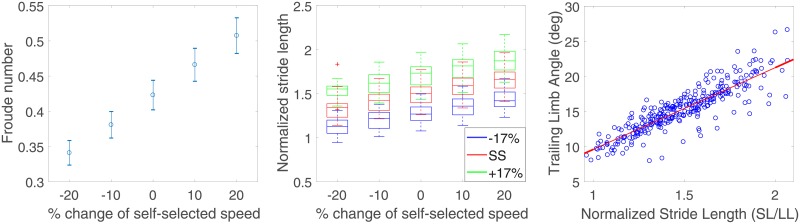
(Left) the distribution of mean Froude numbers with 95% confidence intervals at the various treadmill imposed GSs, (center) normalized stride lengths measured at various speeds and biofeedback conditions.The box plot shows the median as a horizontal line, and the box at 25% and 75% percentiles, with whiskers extending to ±3σ, and (right) mean trailing limb angle and mean normalized stride length for each of the 15 conditions for each of the 20 subjects. Linear regression indicates that there is a strong correlation (r = 0.87) between the two measures.